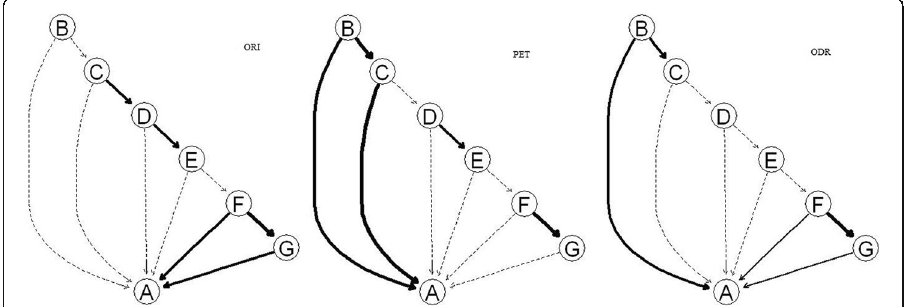
Fig. 4 The extracted Bayesian network for volatility in each sector, obtained by the score-based algorithm. The solid/dashed lines refer to statistically significant/insignificant arcs, respectively. The letters represent A σ 2 , B σ 2 , C σ 2 , D σ 2 , E σ 2 , F σ 2 , G σ 2 t t − 1 t − 2 OVX ; t − 1 OVX ; t − 2 OPEC ; t − 1 OPEC ; t −